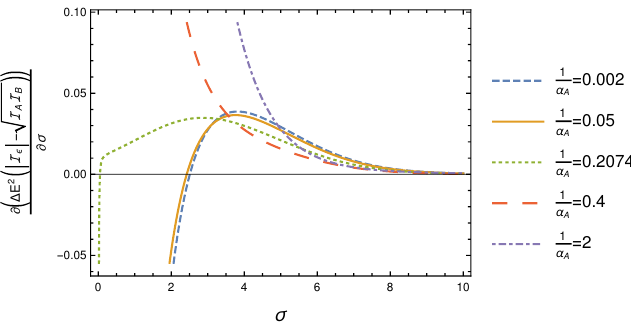
√ (cid:0) (cid:1) |I ε | − I A I B = 1 B